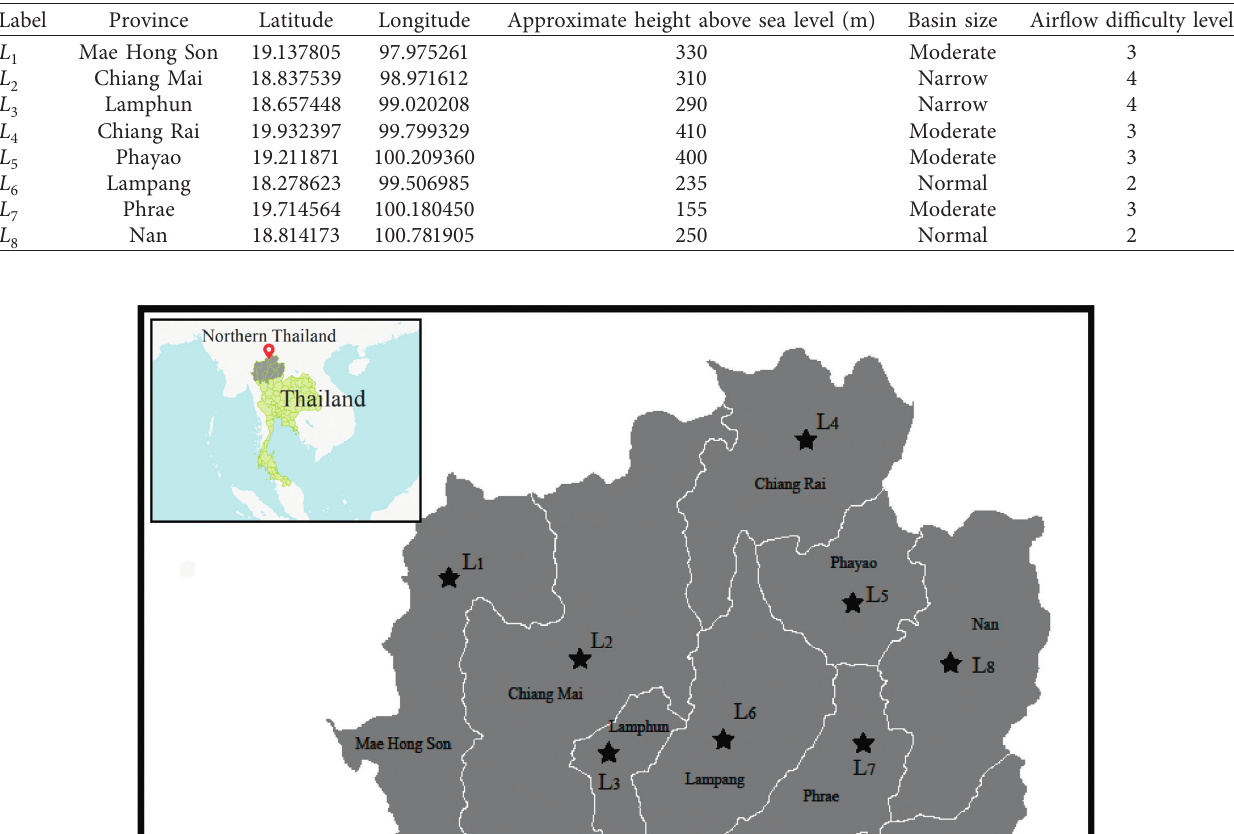
Table 6: Geographic information summary of the study area.